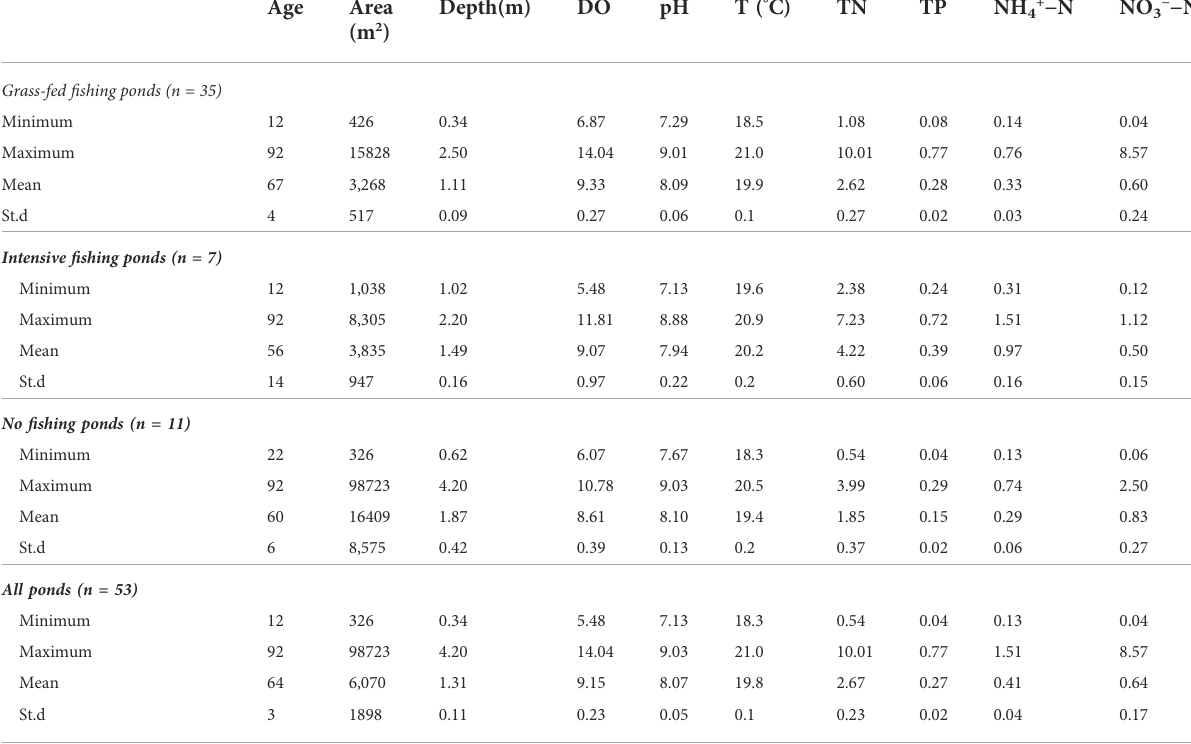
TABLE 1 Descriptive statistics of pond parameters in different management types of